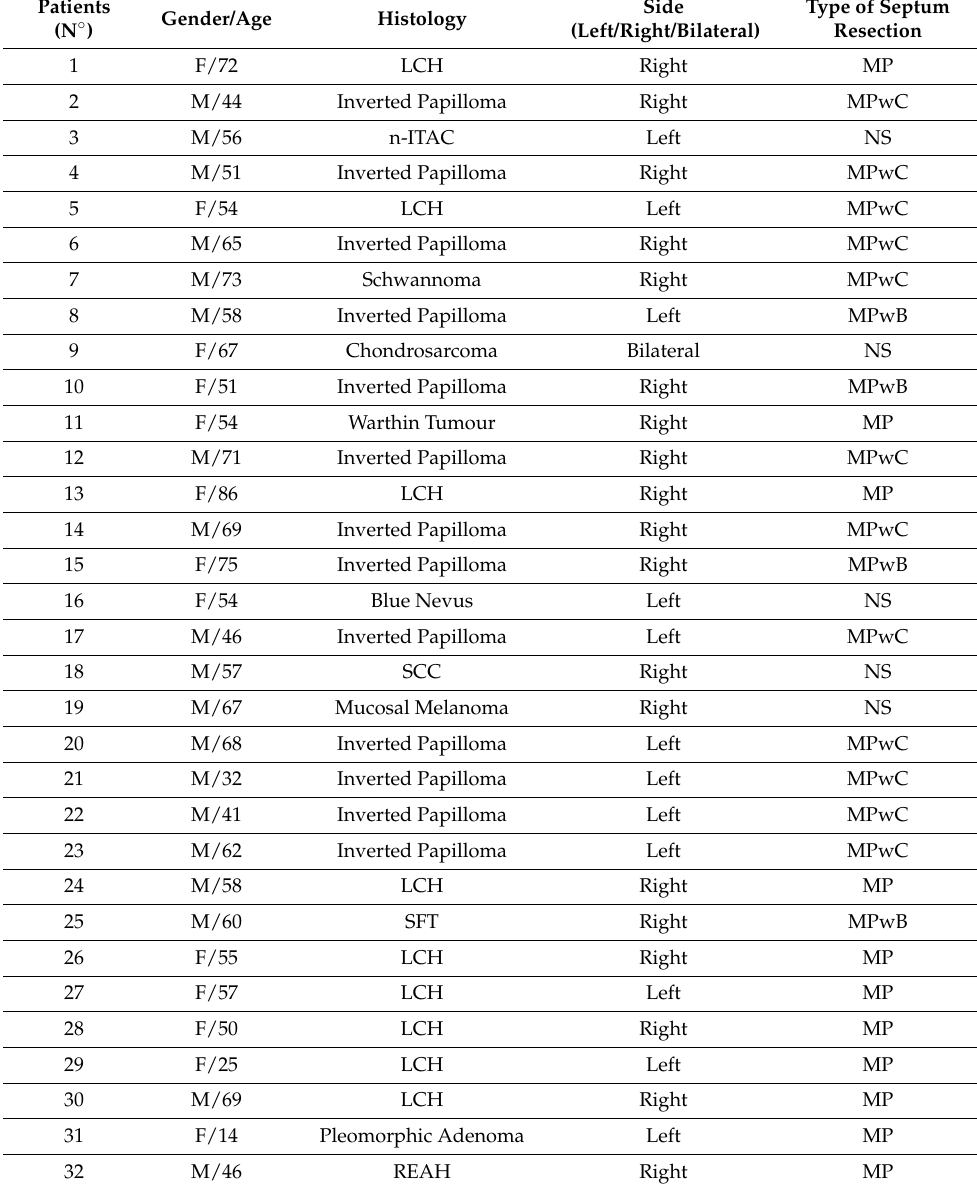
Table 1. Details of patients who underwent endoscopic exeresis of tumour of nasal